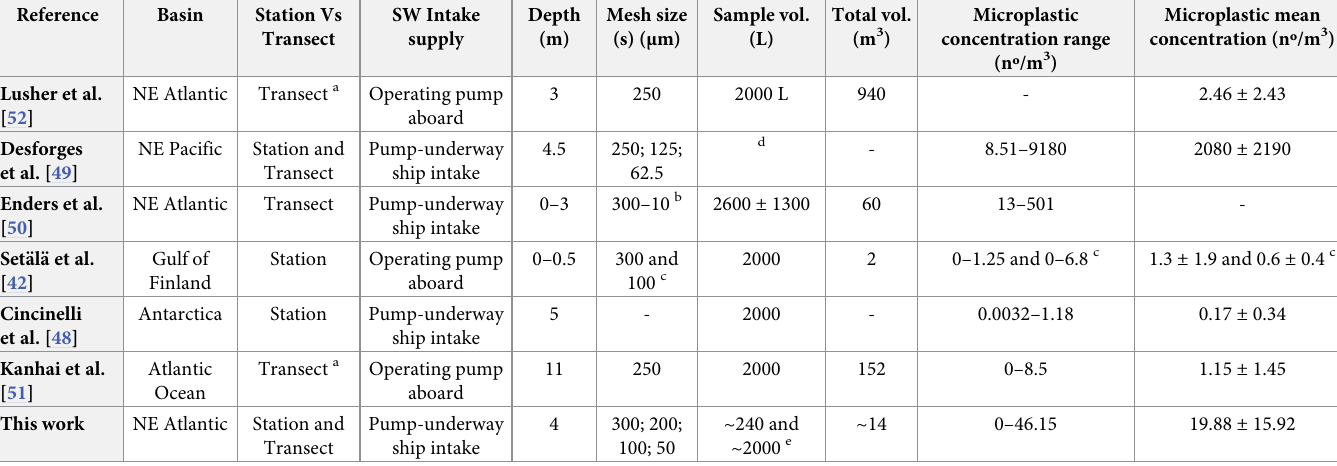
Table 2. Studies that performed similar continuous microplastic sampling pumping seawater on board research